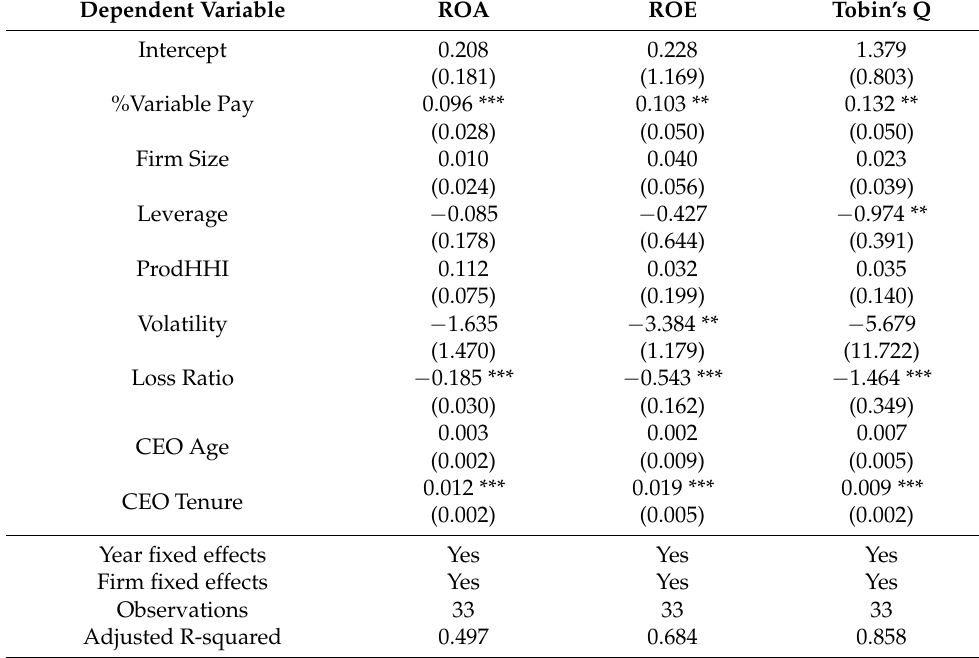
Table 5. Effect of Variable Pay on Firm Performance (Korean Non-life Insurance Firms) using the Bootstrap